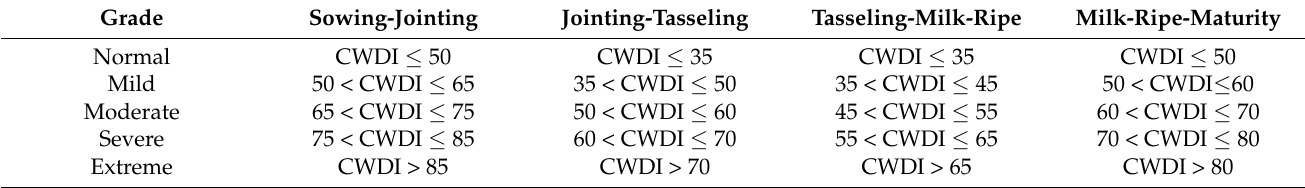
Table 2. Classification standard for drought based on the CWDI (Crop water deficit index). Jointing-Tasseling